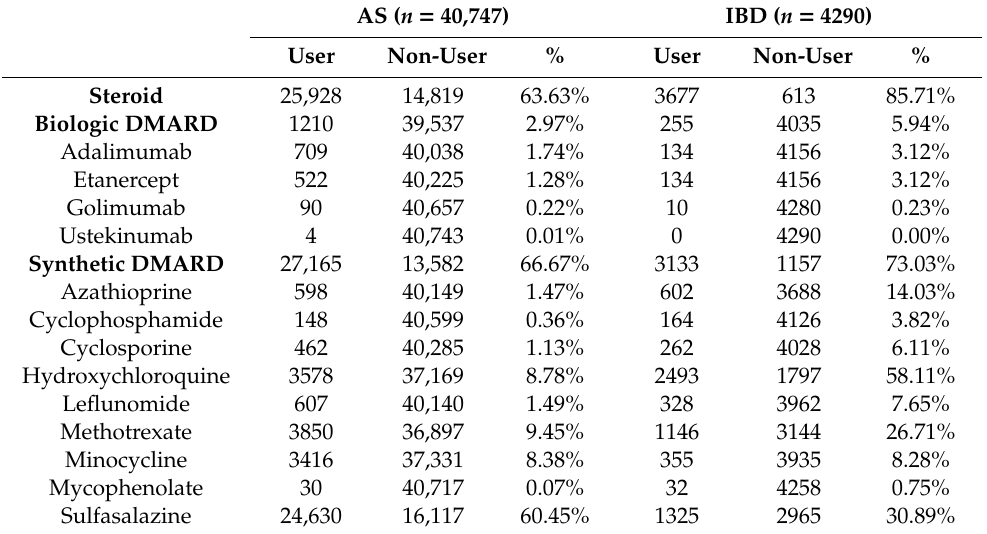
Table 3. Frequency of corticosteroid and disease modifying anti-rheumatic drug usage among patients with ankylosing spondylitis and inflammatory bowel disease during the study